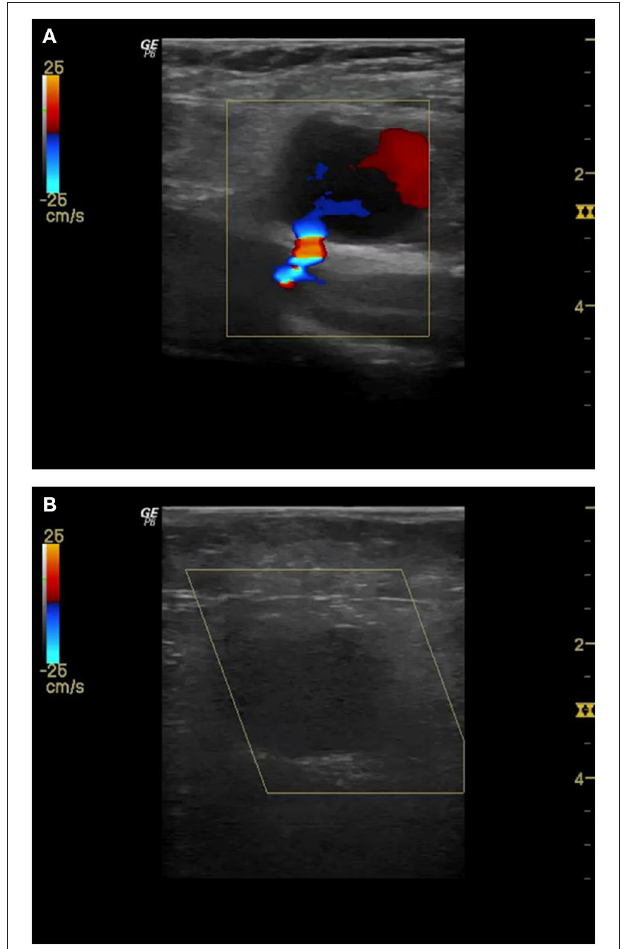
FIGURE 2 | Pseudoaneurysm with clearly visible bleeding from common femoral artery (CFA) after TAVI (A) . Since compression with the ultrasound-probe shows no success even after 30min and an ultrasound-guided injection of 500 IU thrombin is performed. Subsequently, complete closure of the pseudoaneurysm (B)